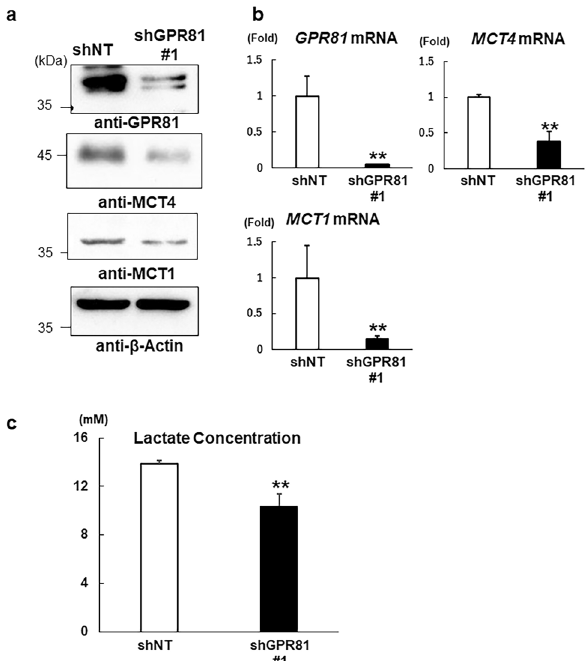
Figure 2. Stable knockdown of GPR81 in MDA-MB-231 cells. Using a lentiviral system, GPR81 was stably knocked down in MDA-MB-231 cells with GPR81-specific short hairpin RNA (shGPR81 #1) and compared with cells containing scrambled shRNA as a control (shNT). Knockdown of GPR81 was confirmed by ( a ) western blotting and ( b ) RT-qPCR. The GPR81 , MCT1 , and MCT4 mRNA levels in the shGPR81 #1 cells are presented as the fold increase compared with those in shNT cells. Data are presented as the means ± s.d. ( n = 3/ group). ** p < 0.01; Student’s t- test. ( c ) Lactate production in shNT and shGPR81 #1 cells. The cells were cultured for 24 h and lactate concentrations in the supernatants were determined ( n = 3/group). ** p < 0.01 (vs. shNT cells); Student’s t-